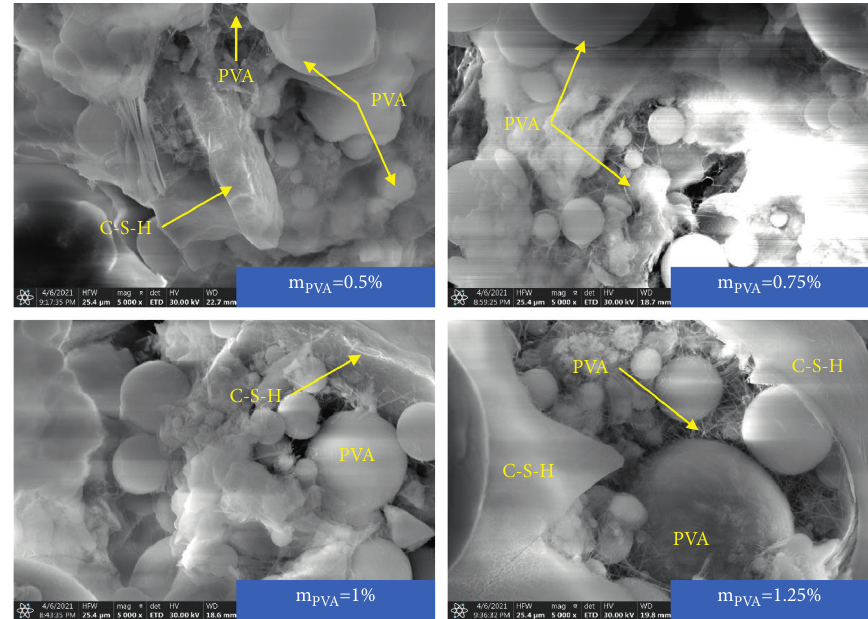
Figure 13: SEM images of nonsintered bricks with different polyvinyl alcohol doping levels (muck 45%, lime 10%, cement 5%, and fly ash